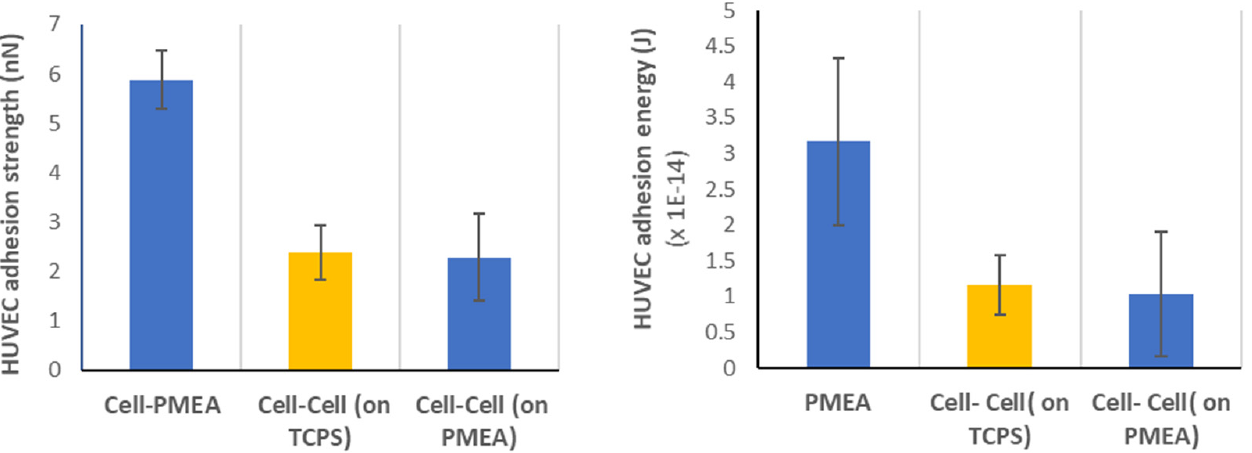
Figure 5. Comparison of HUVEC adhesion strength between cell-PMEA, cell-cell cultured on TCPS, and cell-cell cultured on PMEA. The data represent the mean ± SD (n > 4).